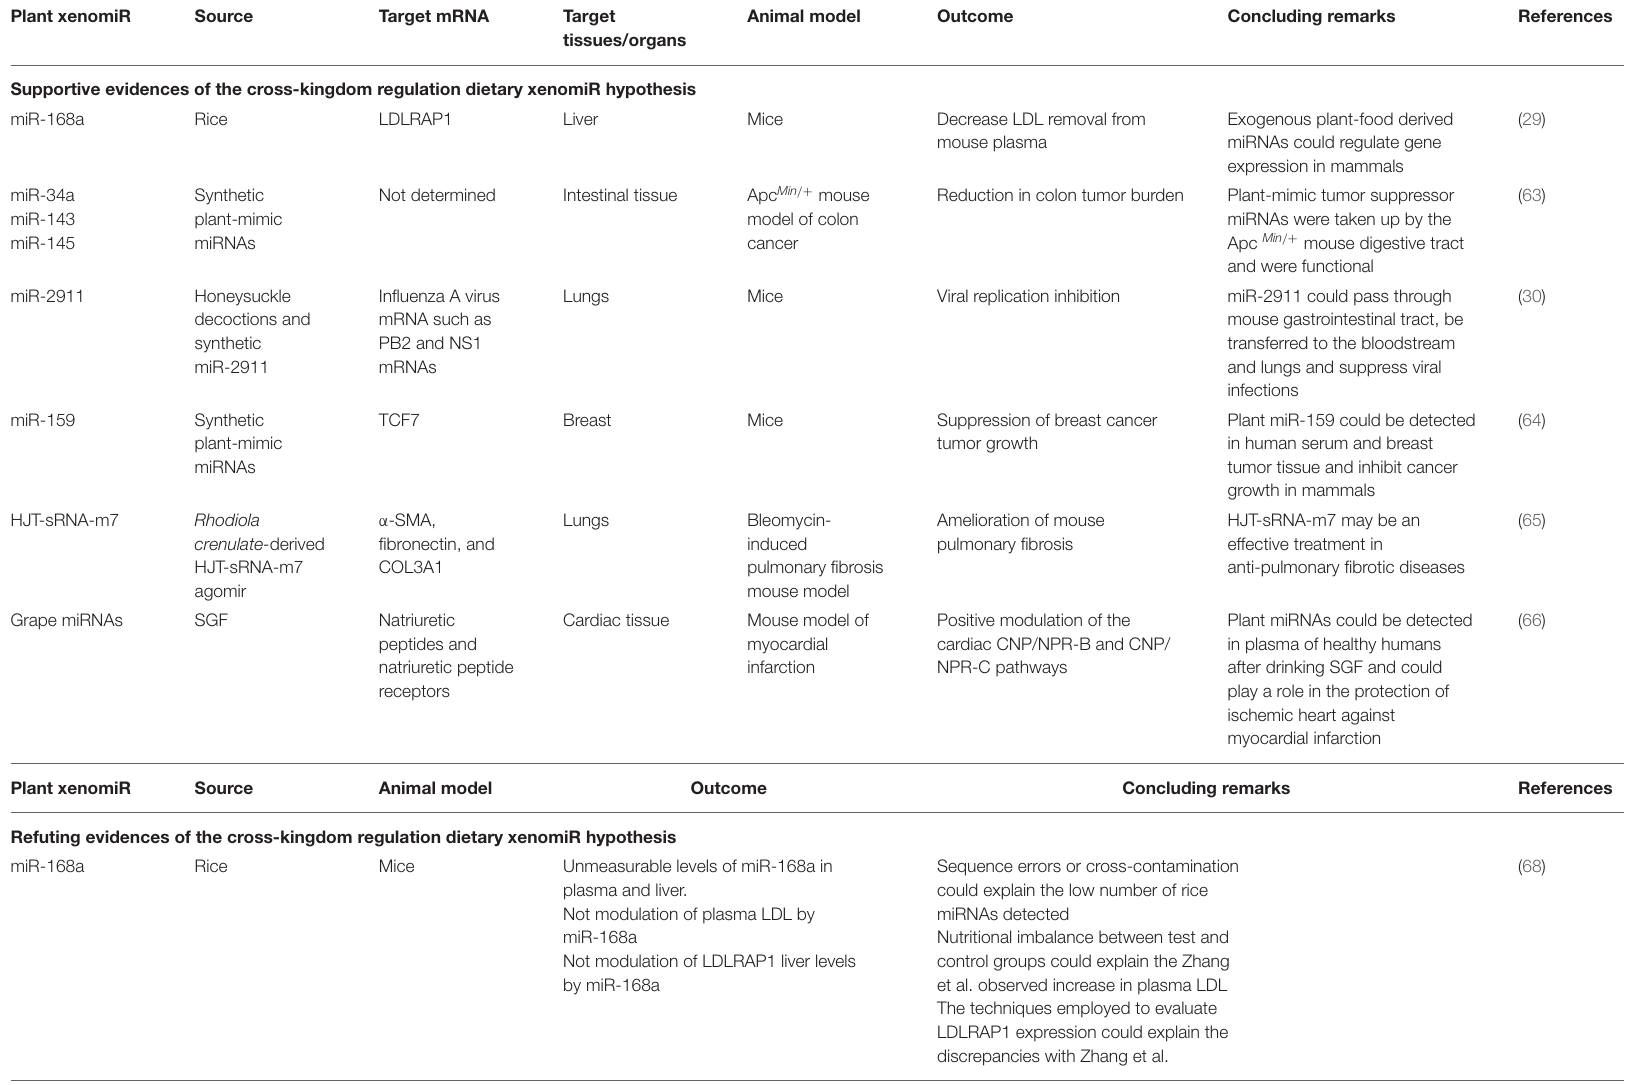
TABLE 1 | Some evidences for and against the detection of plant-derived xenomiRs on mammalian fluids and